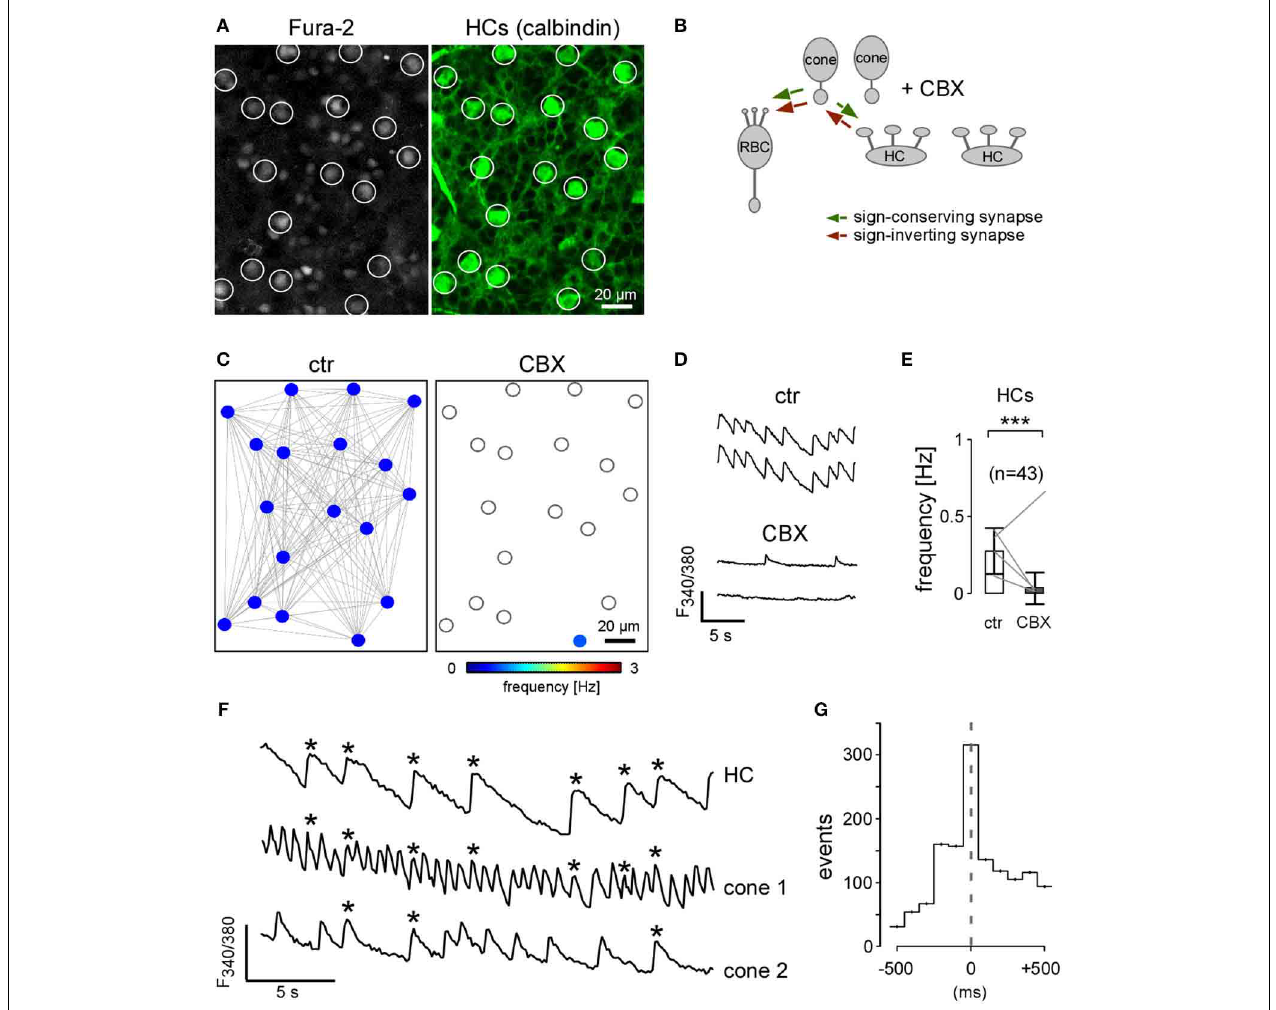
FIGURE 7 | Horizontal cells form a large electrically coupled network in the rd1 retina. (A) Left: Fura-2-labeled outer retinal neurons in P35 rd1 retina (open circles mark HC cell bodies). Right: consecutive immunolabeling of the same region for calbindin confirmed that the cells are HCs. (B) Drawing shows that the gap junction blocker carbenoxolone (CBX) blocks coupling between HCs (and cones). (C) Activity map before (ctr) and during the